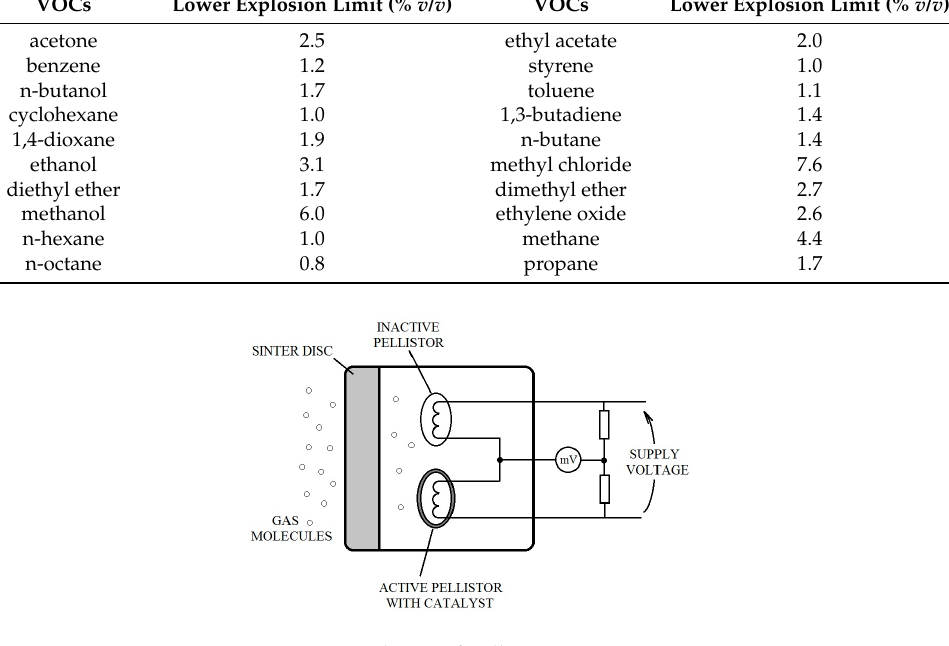
Figure 6. Scheme of pellistor-type sensor.